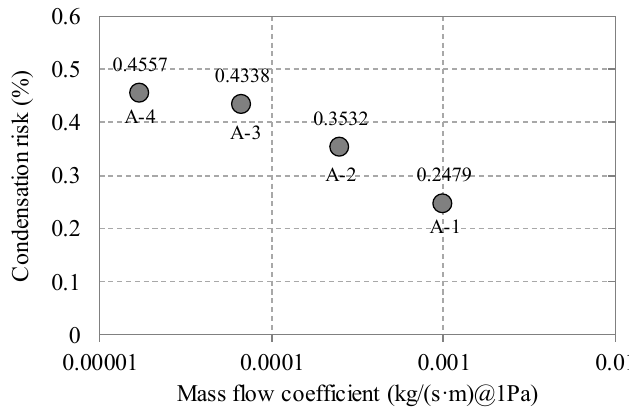
Figure 8. Condensation risk under varying airtightness conditions.